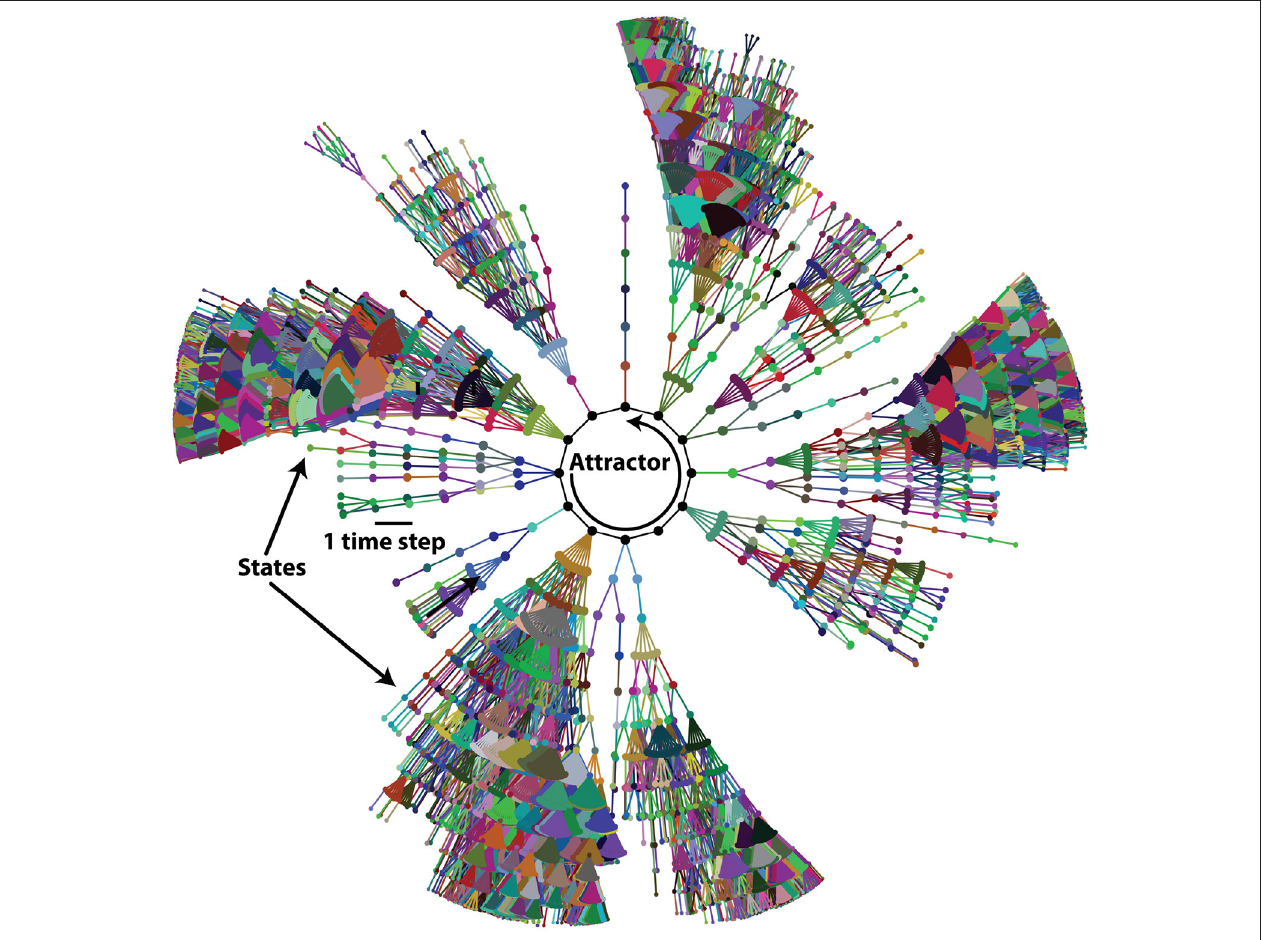
FIGURE 3 | Basin of attraction of one attractor of the acrosome reaction (AR) network. Network states are symbolized by dots and links between dots represent the single-step state transitions. The network eventually reaches the attractor, symbolized by black dots at the center, connected with solid black lines. For clarity, only states at 13 or less time steps away from the attractor are